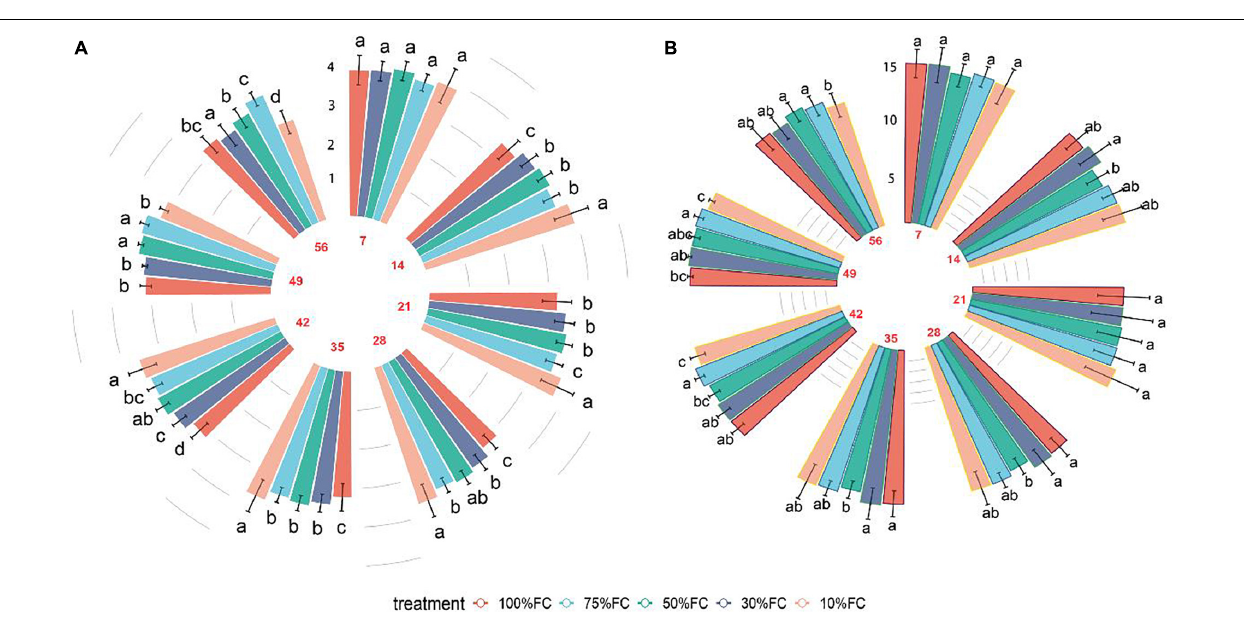
wavelength range (Min and Lee, 2005). Similarly, our study found that the N content was most significant at 2,210 nm, confirming the accuracy of our variable selection